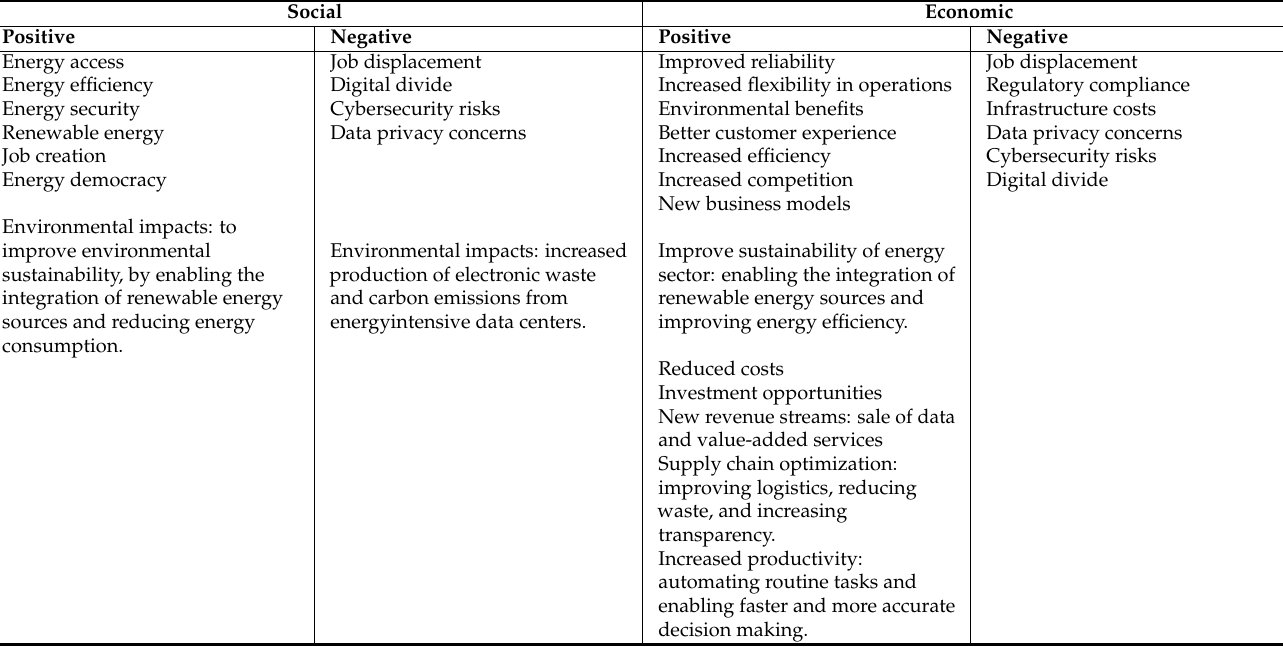
Table 7. Socio-economic impacts of digital transformation on power